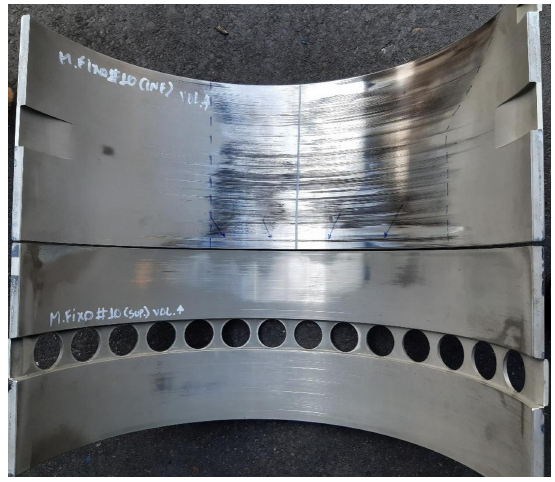
Figure 13. Photography of one of the disassembled bearing